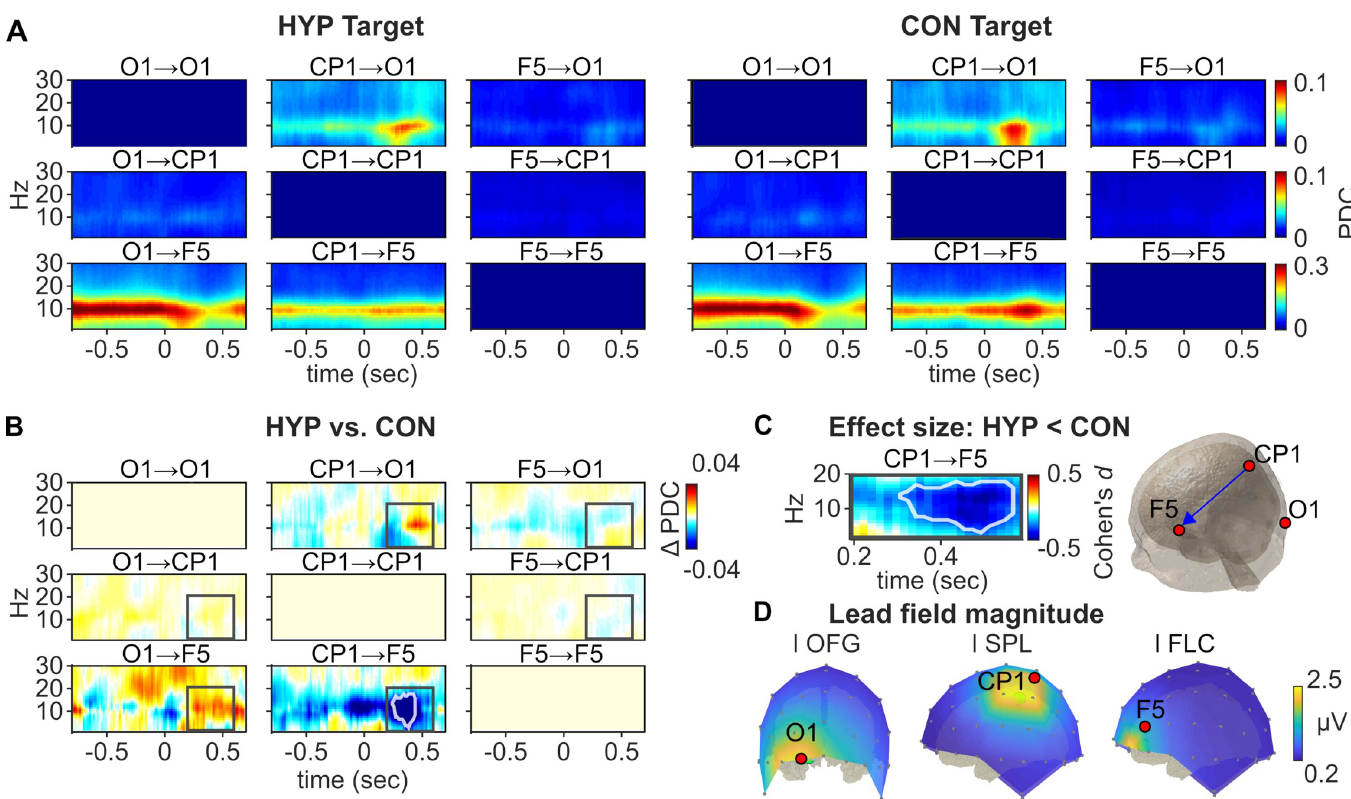
Fig 5. Spectrotemporal connectivity within the network of three electrodes (O1, CP1, F5) at the left hemisphere across all participants ( n = 60). (A) Evolution of the pairwise connectivity during the hypnosis (HYP, left) and control (CON, right) condition for the target stimulus. The connectivity values represent the time-variant partial directed coherence (PDC) from 1 to 30 Hz within the latency range of − 800 to 700 ms relative to the target stimulus. Note, that directed information flow is mainly located in the low frequency range (8 − 12 Hz) both in HYP and CON. (B) Absolute difference of the connectivity matrices between HYP and CON. Warmer colours (red) indicate HYP > CON and cooler colours (blue) CON > HYP. The grey rectangle marks the spectrotemporal region of interest (ROI) that was used for statistical comparison of both conditions. (C) Effect size expressed as Cohen’s d for the statistically significant ROI difference in spectrotemporal connectivity between HYP vs. CON. White lines in (B) and (C) encircle the significant spectrotemporal region at p < .05 corrected for multiple comparisons in the time-frequency plane using cluster-based statistics. (D) Lead field magnitude ( μ V) of three source cluster peaks located in the left hemisphere: the occipital fusiform gyrus (l OFG), the superior parietal lobe (l SPL), and the frontolateral cortex (l FLC). The maximum lead field magnitude of these source cluster peaks defined three electrodes as suitable representatives of these structures that were selected for the connectivity analysis.